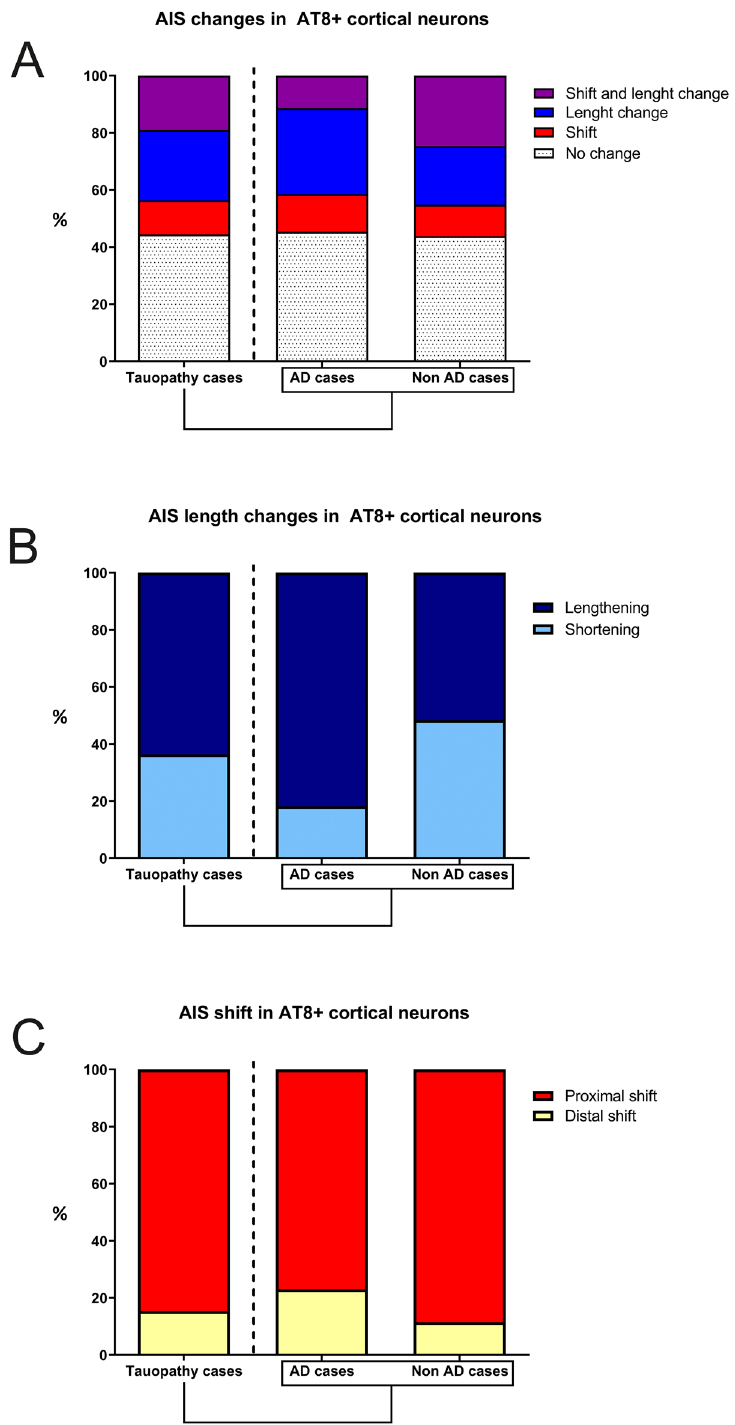
Figure 4. Histograms showing—in all tauopathy cases (left column), in AD cases (middle column) and in control cases (right column)—the percentages of AT8-immunopositive neocortical neurons with different AIS changes ( A ), with different AIS length changes ( B ) and with different types of AIS shift ( C ). Adobe Photoshop CS4 software was used to compose figures. Imaris software was used to measure—in 3D—the AIS length and/or